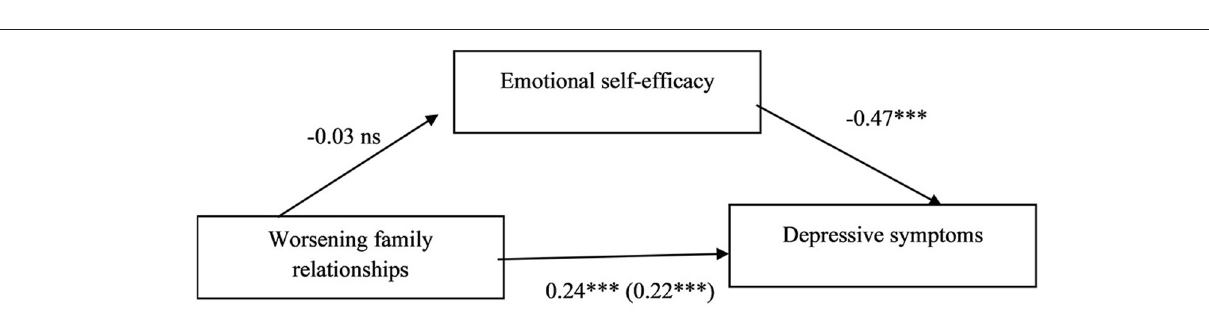
FIGURE 2 | Standardized regression coefficients (beta) for the relation between worsening in family relationships and depressive symptoms as mediated by emotional self-efficacy. * p < 0.05; ** p < 0.01; and *** p < 0.001. In parenthesis the standardized regression coefficient between the independent variable and the dependent variable controlling for the mediator Gender beta = − 0.25***. R 2 = 0.31; F (3, 292) = 44.00, p <